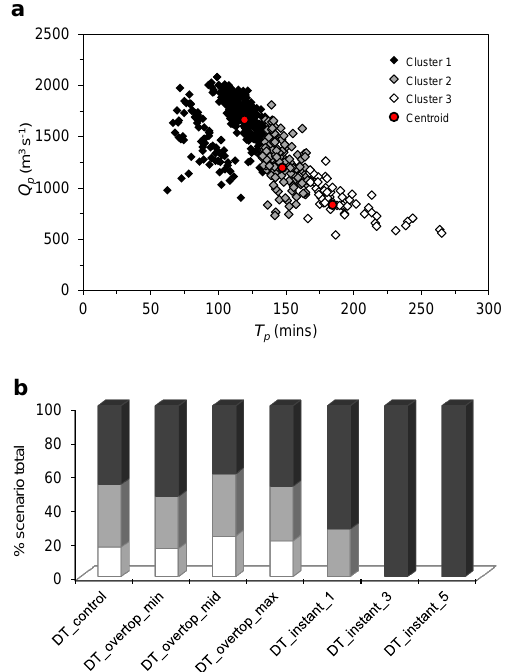
Figure 11. Data clustering. (a) Cluster membership following application of a subtractive clustering algorithm in MATLAB ® ; (b) cluster membership as a function of total scenario-specific be- havioural simulations (%). For key see (a)